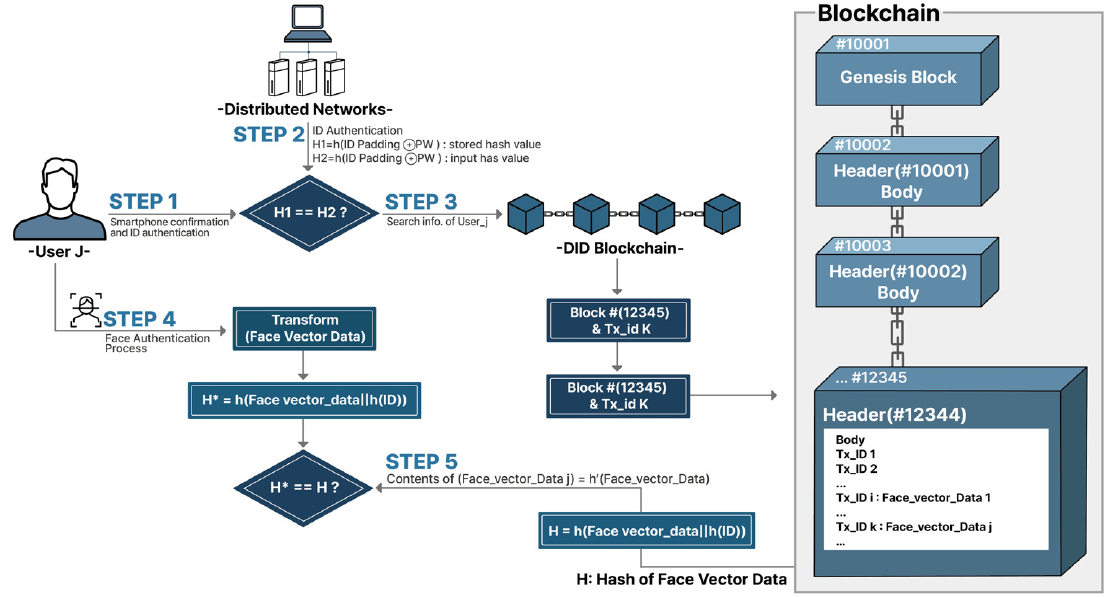
Figure 8. Step-by-step process.